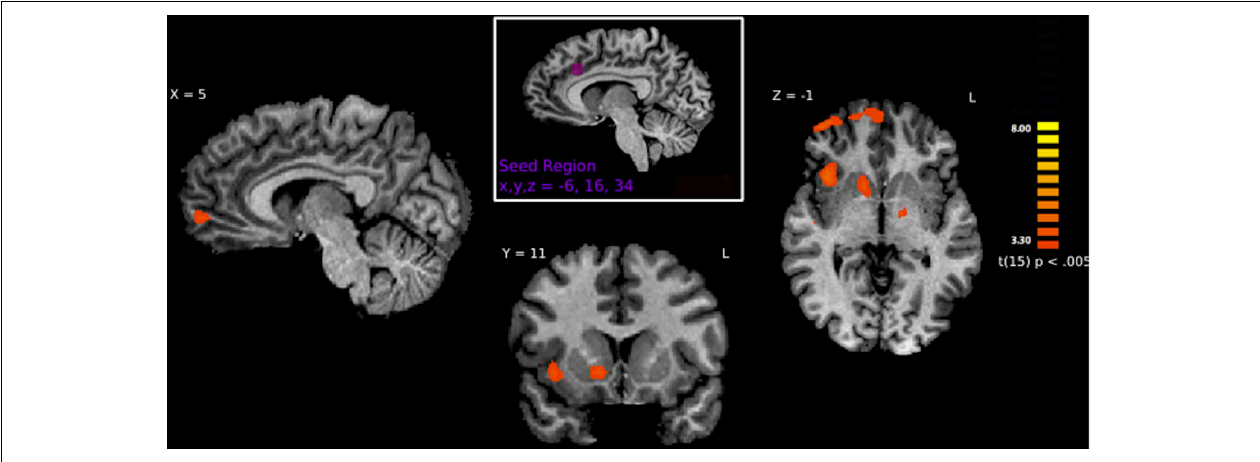
pain. Specifically, connections are shown to the right anterior insula, right frontal pole, right nucleus accumbens and right medial prefrontal cortex.